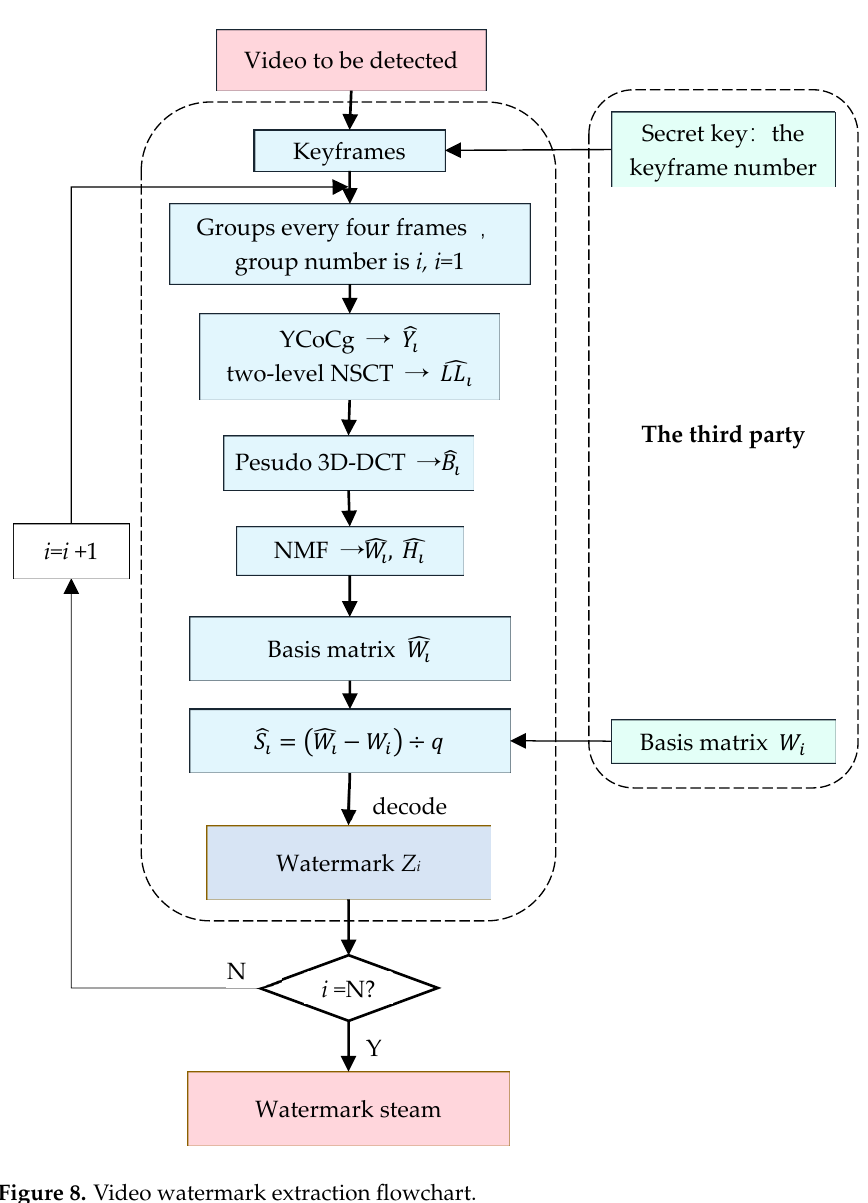
Figure 9. An example of video watermark extraction.